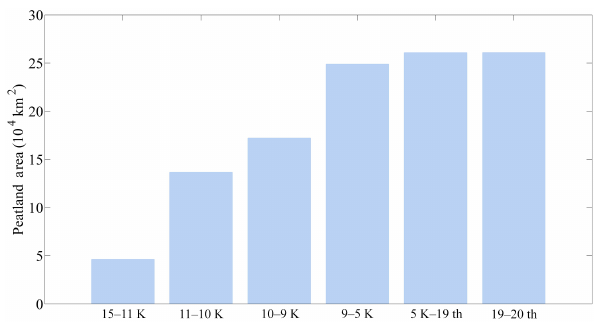
Figure 9. Peatland expansion area (10 4 km 2 ) in different time slices.